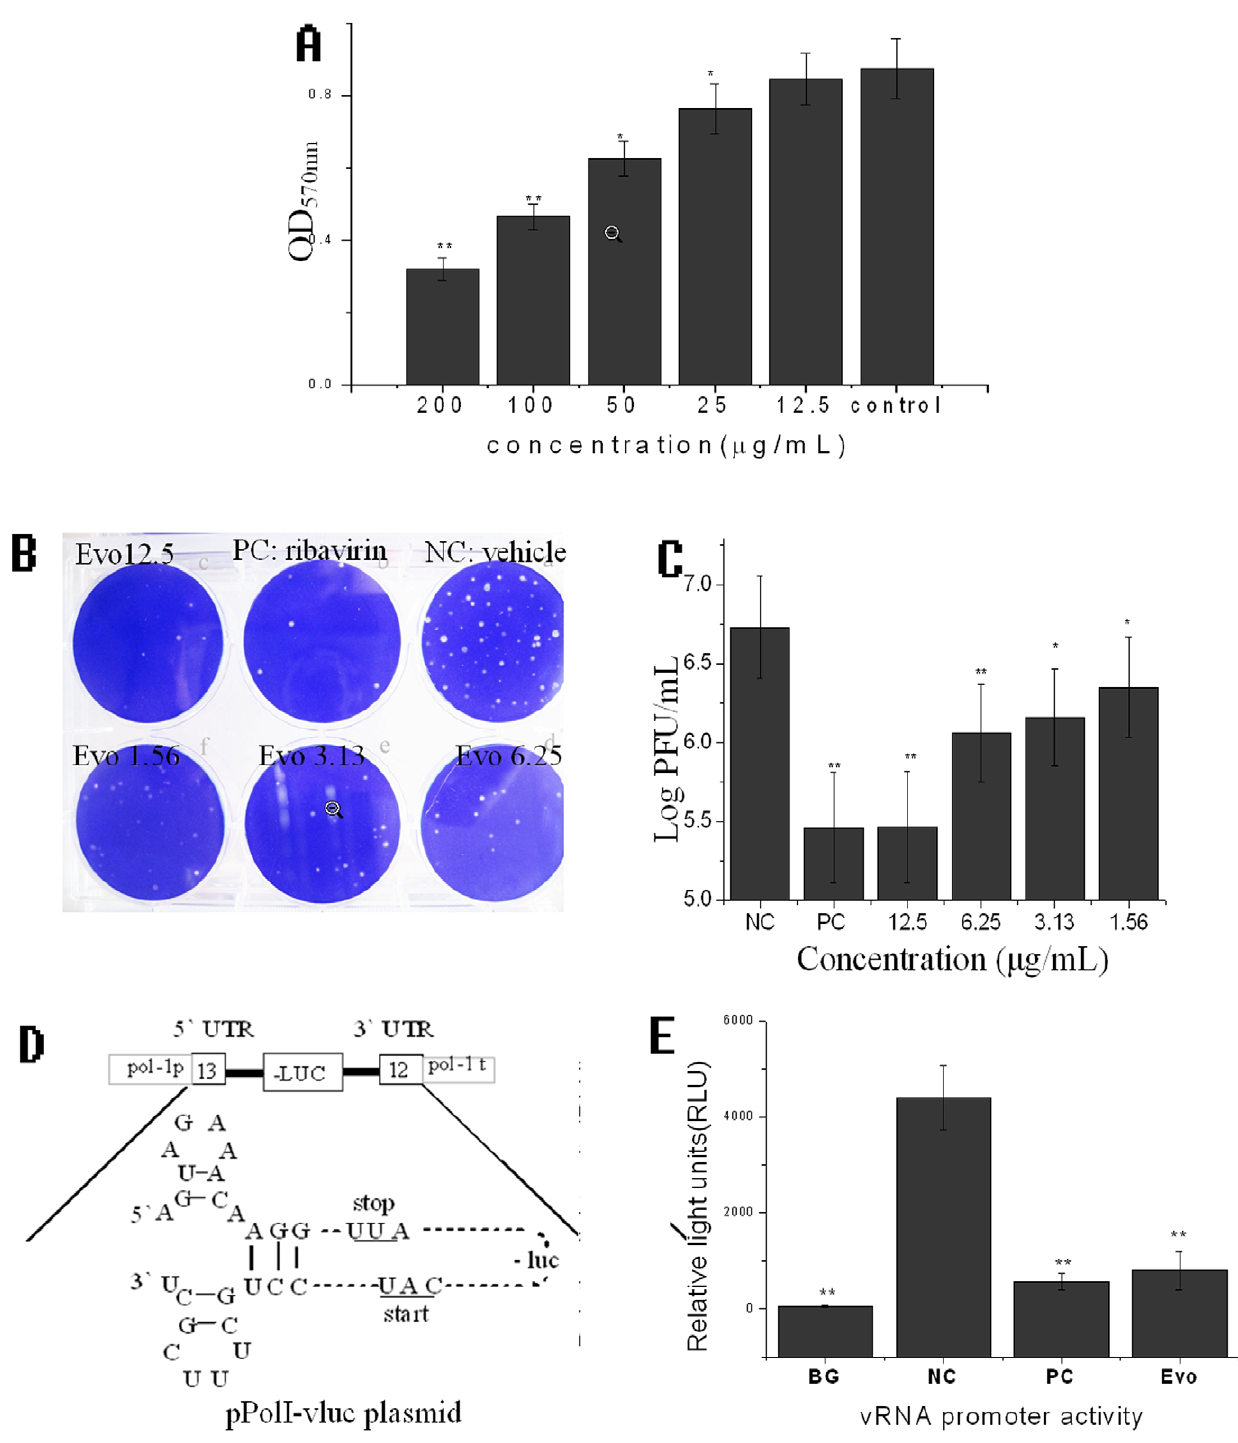
Figure 3. Evodiamine inhibits the IAV replication. ( A ) The result of the cytotoxicity assay. The cells in the control group were not treated with evodiamine but solvent vehicle (DMSO , 0.5%). ( B ) The plaque inhibition assay of evodiamine. ( C ) The result of the plaque inhibition assay. In the NC group, the cells were infected with IAV, but not treated with drugs; In the PC group, the cells were infected with IAV and treated with ribavirin (25 m g/ ml). MOI=0.001, incubation time=48 h. ( D ) The schematic representation of the vRNA promoter luciferase reporter (pPolI-vluc) plasmid. ( E ) The inhibition of evodiamine on IAV replication using IAV vRNA promoter luciferase reporter plasmid. In the blank group (BG), the cells were transfected with the pPolI-vluc plasmid but not infected with the IAV; In the NC group, the cells were transfected with the pPolI-vluc plasmid and infected with the IAV, but not treated with drugs; In the PC and Evo groups, the cells were transfected with pPolI-vluc, infected with IAV and treated with ribavirin (25 m g/ml) and evodiamine (12.5 m g/ml), respectively; Data shown were the mean 6 SD of two independent experiments of three replicates. * P , 0.05, ** P , 0.01, vs. the NC.